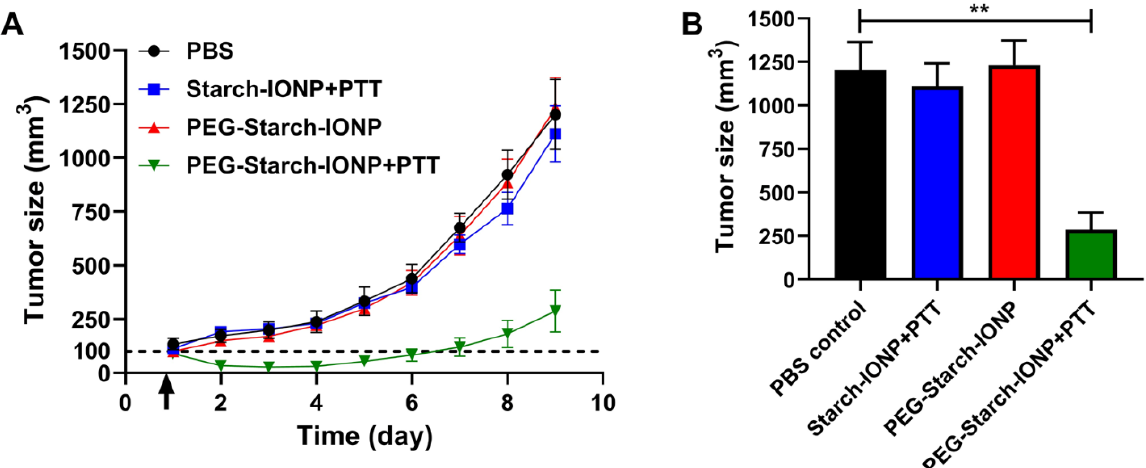
Figure 10. Preliminary efficacy study results (N = 5). ( A ) Tumor growth curves. At day 1 (average tumor size: 100 mm 3 ), U87 MG s.c. tumor-bearing mice were divided into the following four groups: (1) PBS control, (2) starch–IONPs + PTT (starch–IONPs: 24 mg Fe/kg), (3) PEG–starch–IONPs (24 mgFe/kg), and (4) PEG–starch–IONPs + PTT (PEG–starch–IONPs: 24 mg Fe/kg). For groups two and four, at 4 h post-administration, a laser was irradiated for 10 min at the tumor region (at a power of 0.9 W). The study was continued until the average tumor size of the control group reached above 1000 mm 3 (day 9). ( B ) Comparison of the tumor sizes at day 9. The statistically significant differences in the tumor sizes were compared by one-way ANOVA (Tukey’s multiple comparison test as the post hoc test). ** p < 0.01. (PTT: photothermal